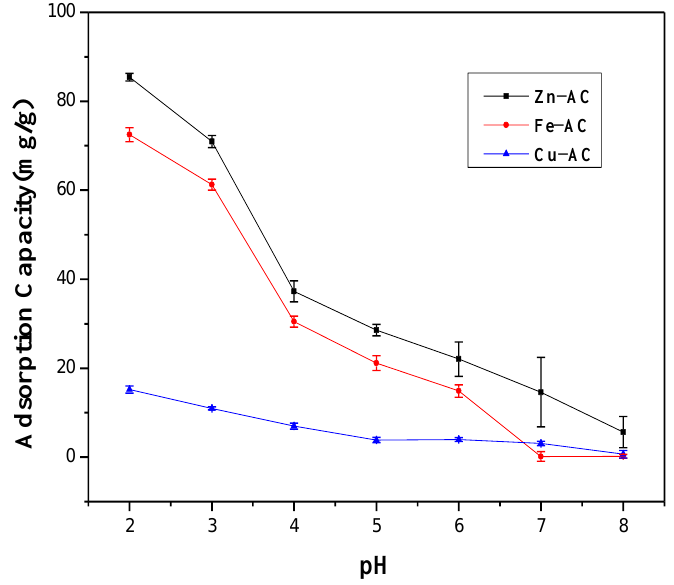
Figure 6. The effect of pH on the adsorption capacities of Cr( Ⅵ ) onto the samples.